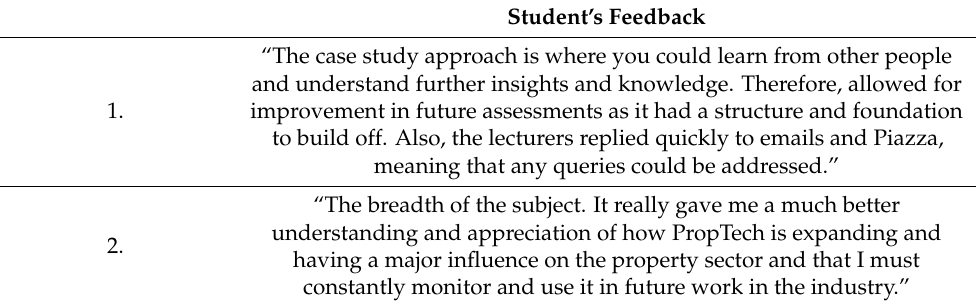
Figure 6. Differences in the student evaluation scores on overall satisfaction, appropriate assessment and assessment feedbacks in 2021 and 2022. Source: Student Evaluation Scores of the PropTech course, 2021 and 2022. Table 1. Some Feedbacks from